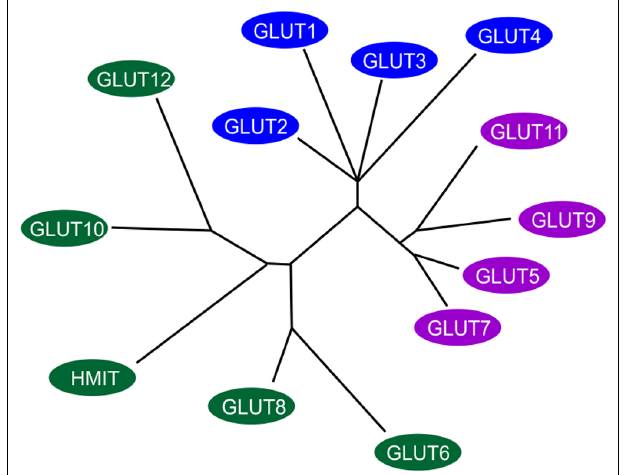
FIGURE 1 | Members of the extended GLUT/SLC2A family. The radial phylogram was derived from a multiple sequence alignment of the 14 known members of the human GLUT/SLC2A family.The tree was constructed using neighbor-joining analysis of a distance matrix generated with PHYLIP software.The family is divided into three classes of GLUT proteins; class I includes GLUTs1-4 and GLUT14; class II includes the fructose transporter GLUT5, GLUT7, GLUT9 and GLUT11; class III includes GLUT6, GLUT8, GLUT10, GLUT12, and the H + -coupled myo-inositol transporter, HMIT. Adapted and modified fromWood andTrayhurn